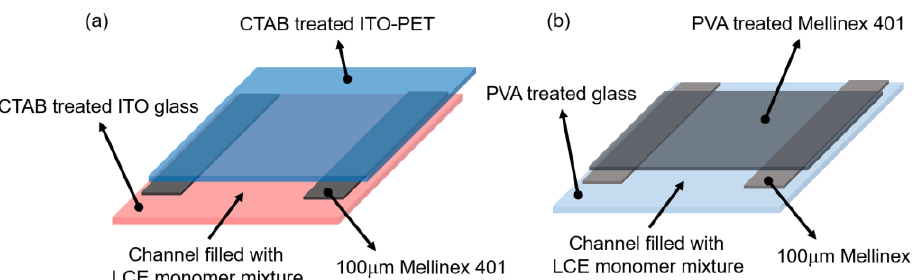
Figure 1. A schematic showing the assembled LCE mold used to fabricate LCEs with ( a ) homeotropic alignment and ( b ) planar alignment.